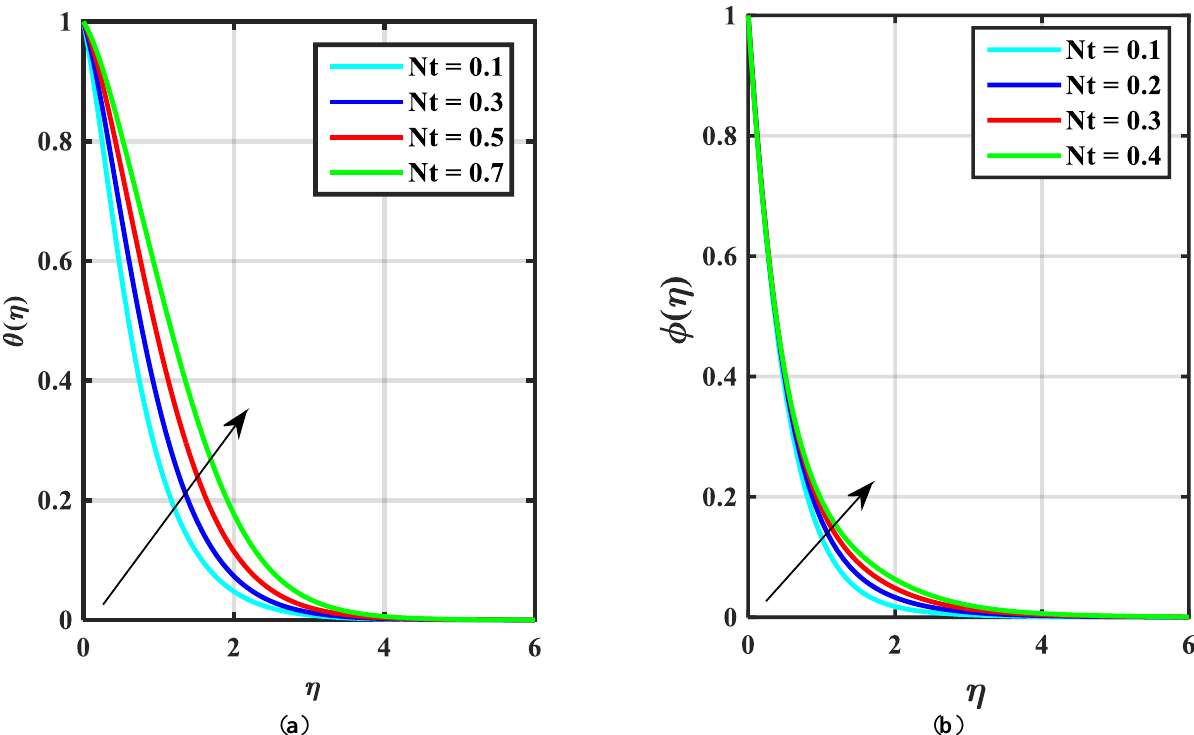
Figure 8. ( a , b ) Influence of 𝜃(𝜂) , 𝜙(𝜂) over thermophoretic parameter 𝑁𝑡 .